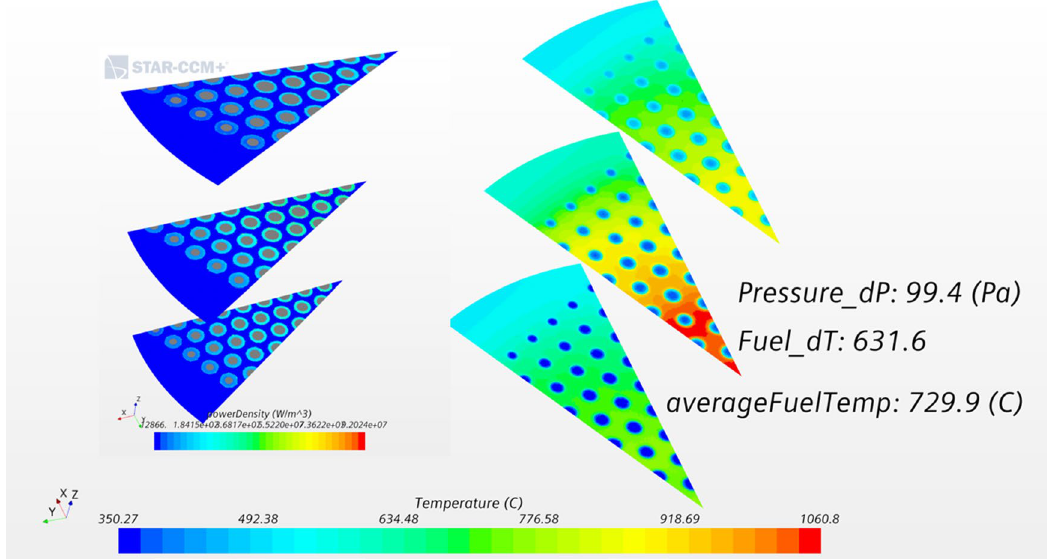
Figure 3. Temperature field from the thermofluidic solution. Three axial sections are plotted at lower, middle, and upper core element levels. They show the temperatures in the coolant, fuel, and moderator. On the left, the power input to the fuel and moderator is provided for reference. Both fuel and channel sizes vary in the radial direction. Created using Star-CCM+, version 2020.1, www. plm. autom ation. sieme ns. com/ global/ en/ produ cts/ simce nter/ STAR- CCM.